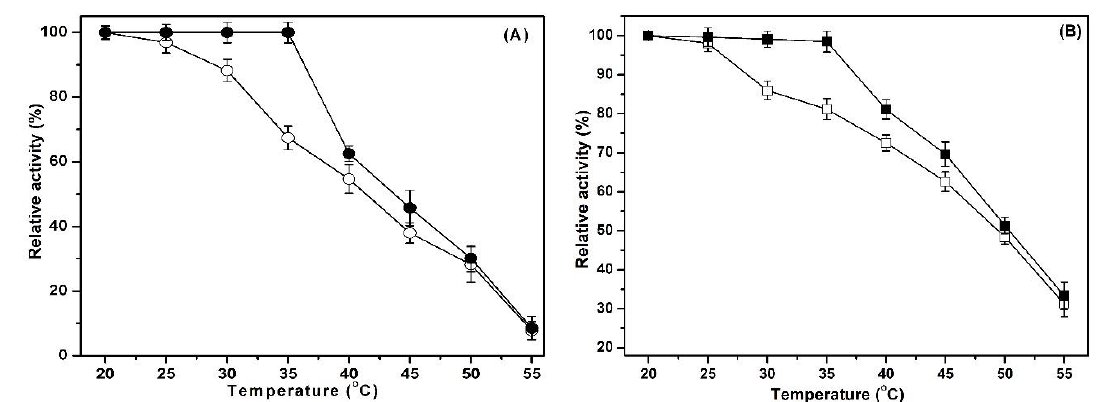
Figure 3. Thermal stability comparison of free and co-immobilized M315F ( A ), thermal stability comparaison of free and At SuSy ( B ).